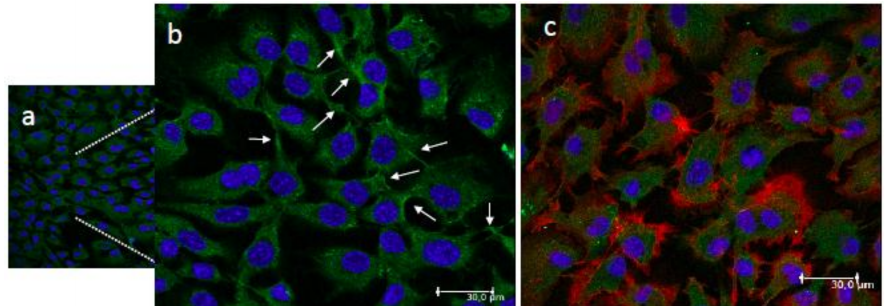
Figure 4. Confocal fluorescence microscopy images showing the adhesion and morphology of MC3T3-E1 pre-osteoblastic cells on the CS- g -PCL surfaces 3 days after seeding (( a , b ); ( b ) is a magnified area of ( a )). Cytoskeletal organization of cells visualized via actin (red), vinculin (green) and nucleus (blue) staining. White arrows show the vinculin focal adhesion points ( b ). An overlay of the three staining is depicted in image ( c ). Cells strongly attach on the material surface and form cell-cell interactions, covering the whole surface area. Original magnifications are 20 × in ( a ) and 40 × in ( b ) and ( c ) with scale bars representing 30 µ